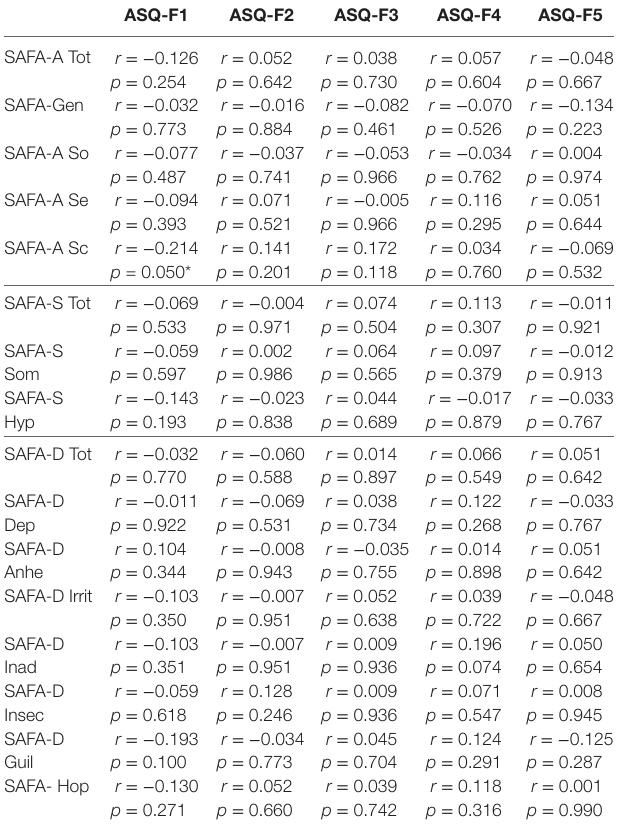
Table 7 | Correlation between ASQ and SAFA-A, S, and D. asQ-F1 asQ-F2